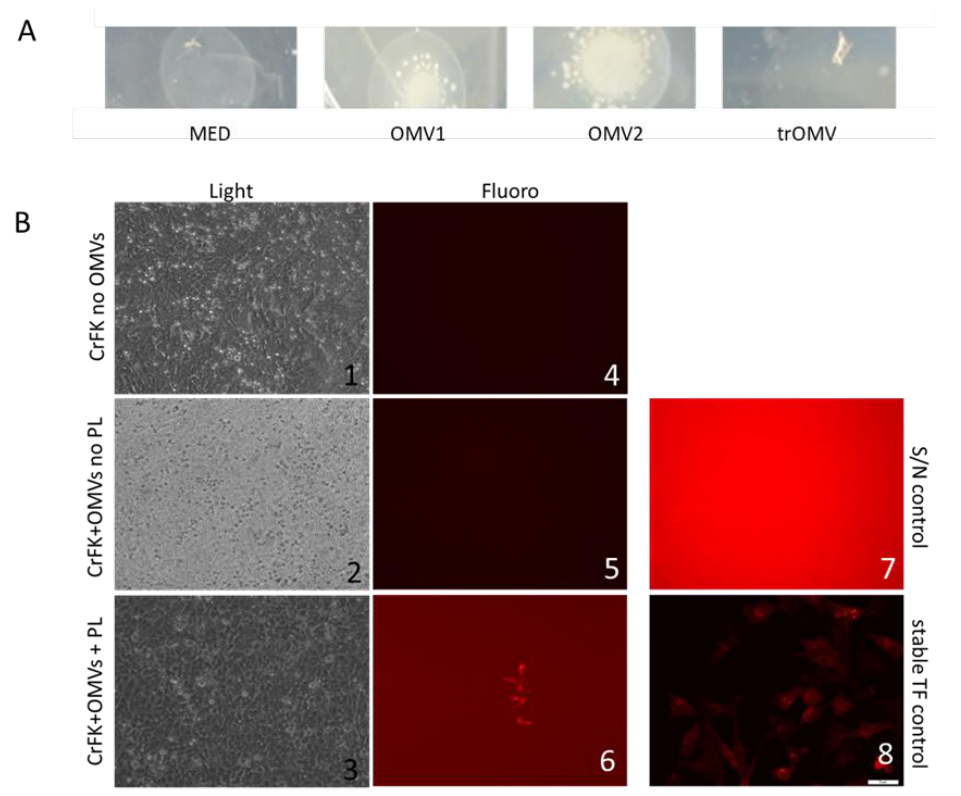
Figure 3. Functional characteristics—property transfer capabilities. ( A ) Prokaryotic: OMVs derived from an ampicillin-resistant E. coli culture were incubated with an ampicillin-sensitive E. coli strain. While the sensitive bacteria did not grow in the absence of OMVs (MED), bacterial growth was observed in the presence of OMVs (OMV1 and 2). When the OMVs were treated with a membrane-active substance (methyl-ß-cyclodextrin) no growth was observed (trOMVs). ( B ) OMVs were derived from an E. coli strain containing an expression construct for the protein fluorophore tdTomato. Different eukaryotic cell lines (CHO, CrFK, HEk293, NIH3T3) were incubated with these OMV preparations. Upon incubation, development of fluorescence was monitored. While in the absence of OMVs (see images 1 and 4) and the presence of OMVs without fluorescence plasmid cargo (see images 2 and 5) no subsequent fluorescence was observed. However, when OMVs containing the expression construct were incubated with the cells, fluorescent cells developed (see images 3 and 6). Image 7 shows an overexposed image to depict signal-to-noise ratio in samples showing no fluorescence. Image 8 shows an overlay picture of CrFK cells stably transfected with tdTomato.